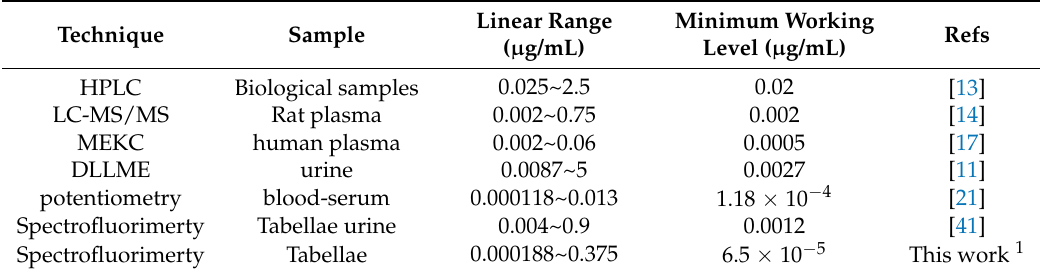
Figure 4. ( A ) The standard curve of AMA ranging from 0.0375 µ g/mL–0.375 µ g/mL ([CB[7] · ABAM] = 2.0 µ M, pH = 4.70, λ ex / λ em = 366/417 nm). ( B ) The standard curve of AMA ranging from 0.000188 µ g/mL–0.0375 µ g/mL ([CB[7] · ABAM] = 0.2 µ M, pH = 4.70, λ ex / λ em = 366/417 nm). Table 1. Various methods and detection limits for the detection of